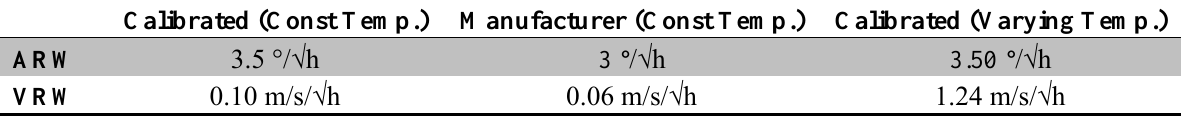
Table 2. Manufacturer and lab calibrated noise (ARW and VRW)